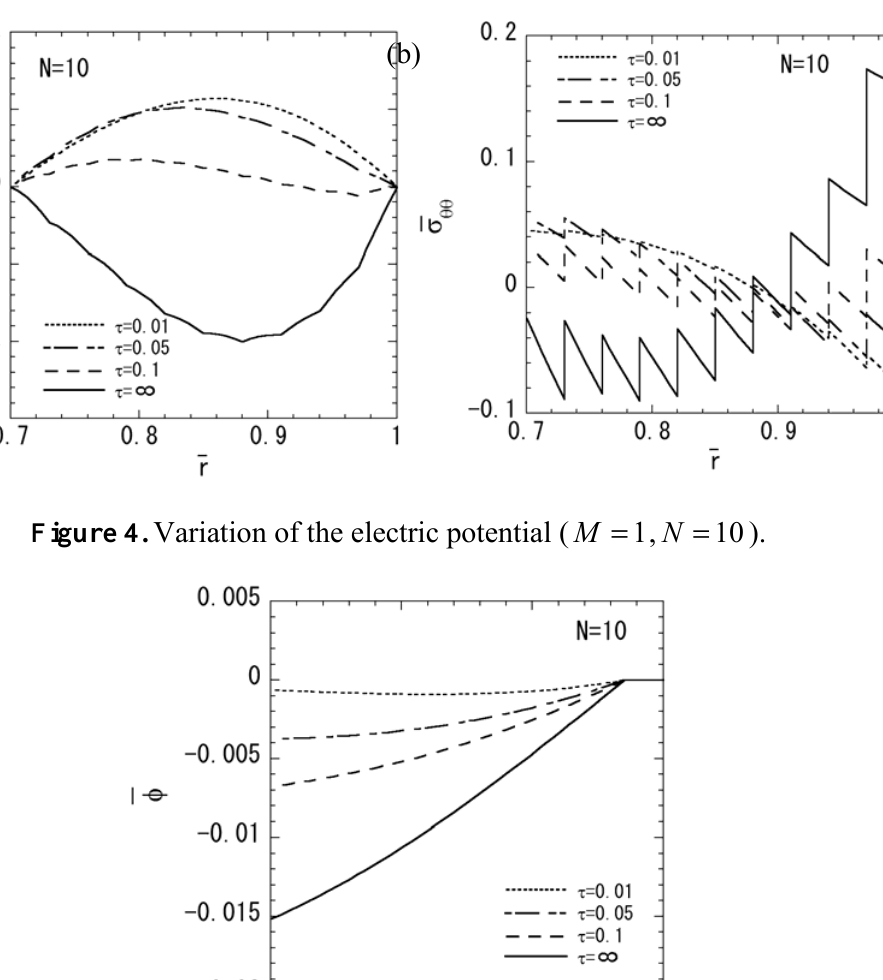
Figure 3. Variation of the thermal stresses (